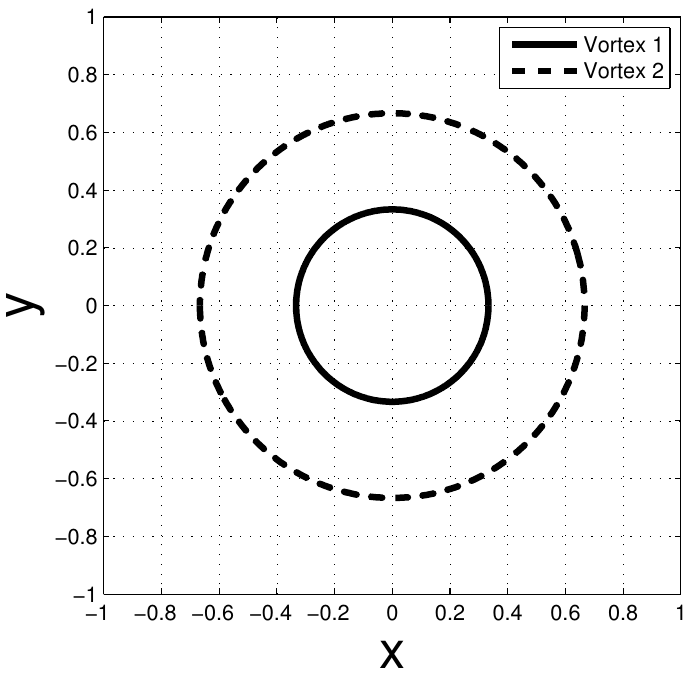
Figure 5. The circular trajectories of the two point vortices rotating about their vorticity center at x C = 0 and y C =